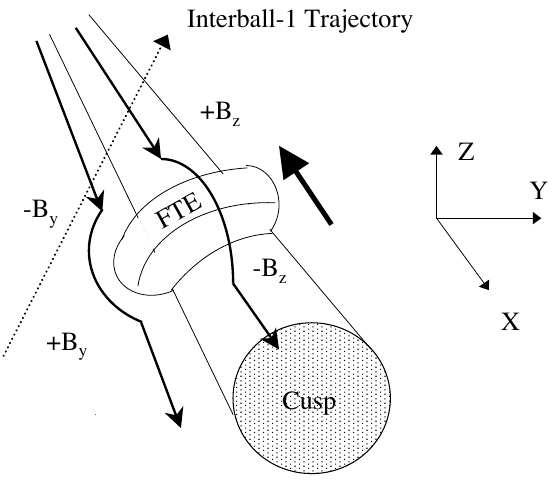
Fig. 7. An interpretation of the Interball-1 observations on 4 July 1998. The southern cusp has finite dimensions in both the y- and z-directions. Field lines point sunward (+x) and diverge in both the y- and z-directions. An antisunward-moving FTE bulges outward from the cusp into the surrounding regions of magnetospheric mag- netic field lines. The passage of this bulge generates bipolar mag- netic field signatures in the direction normal to the nominal bound- ary of the cusp. At locations dawnward of the cusp, the passage of the bulge generates (–,+) B y signatures. At locations northward of the cusp, the passage of the bulge generates (+,–) B z